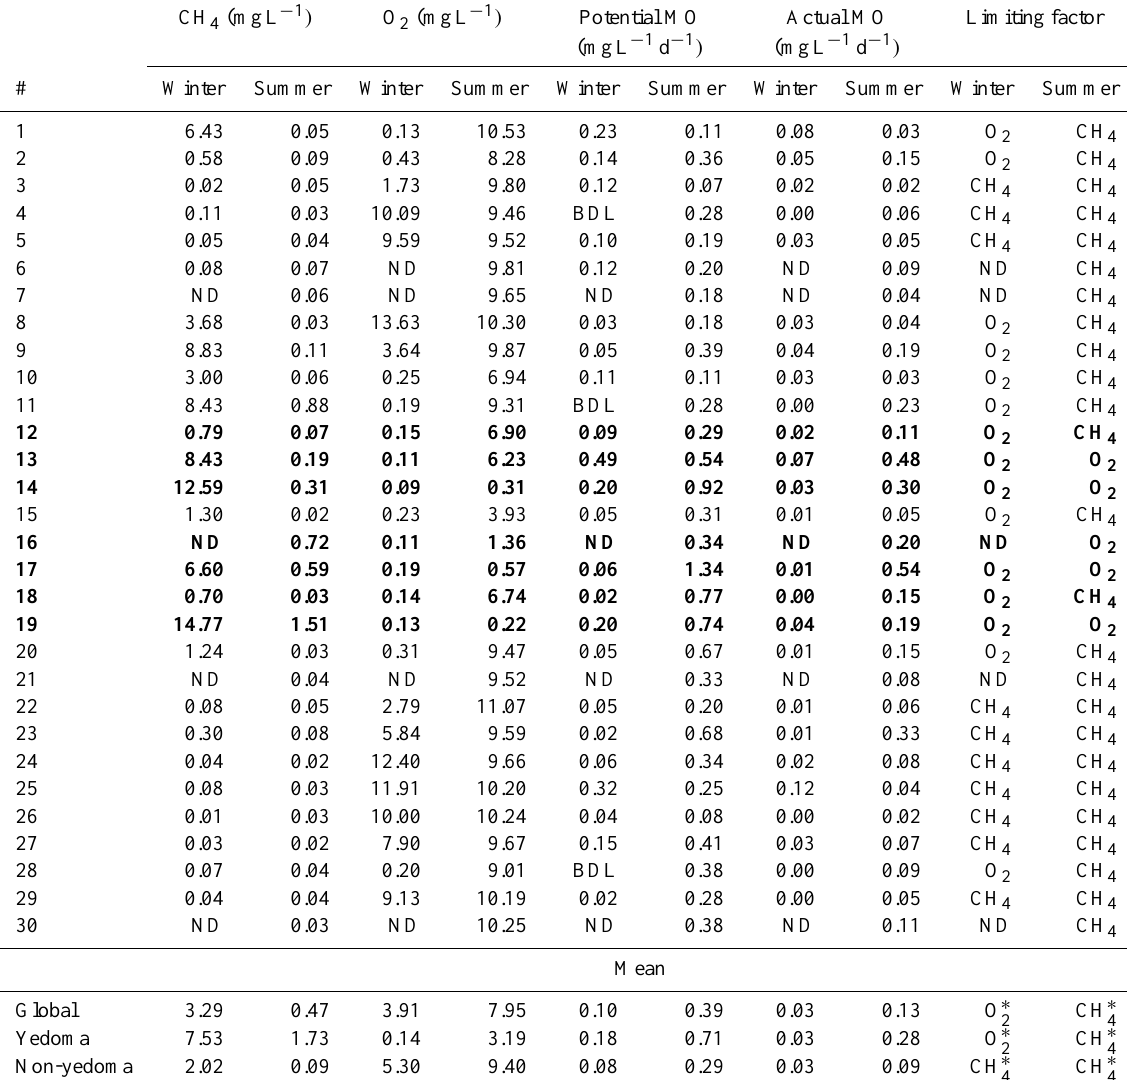
Table 2. Methane oxidation parameters for 30 Alaskan